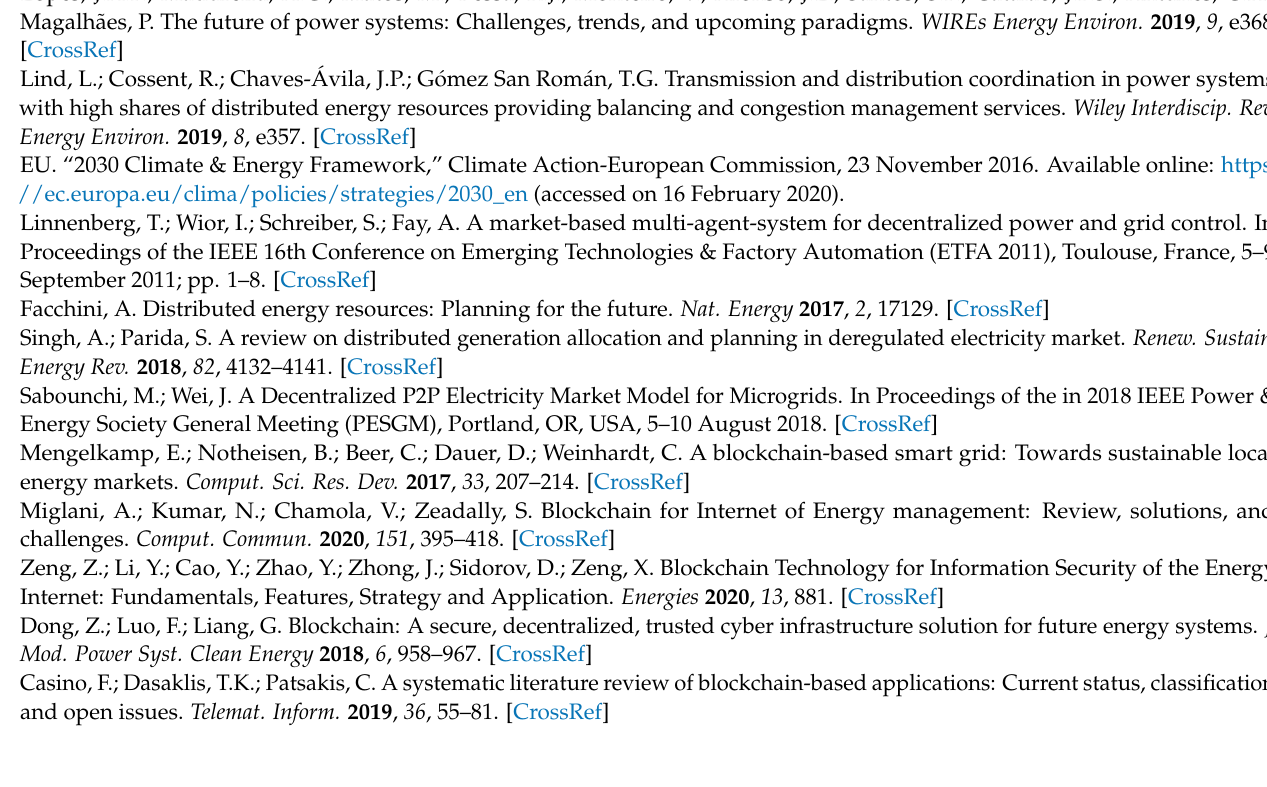
Figure A3. Keyword co-occurrence analysis (using VOS Viewer)—a time-based view.